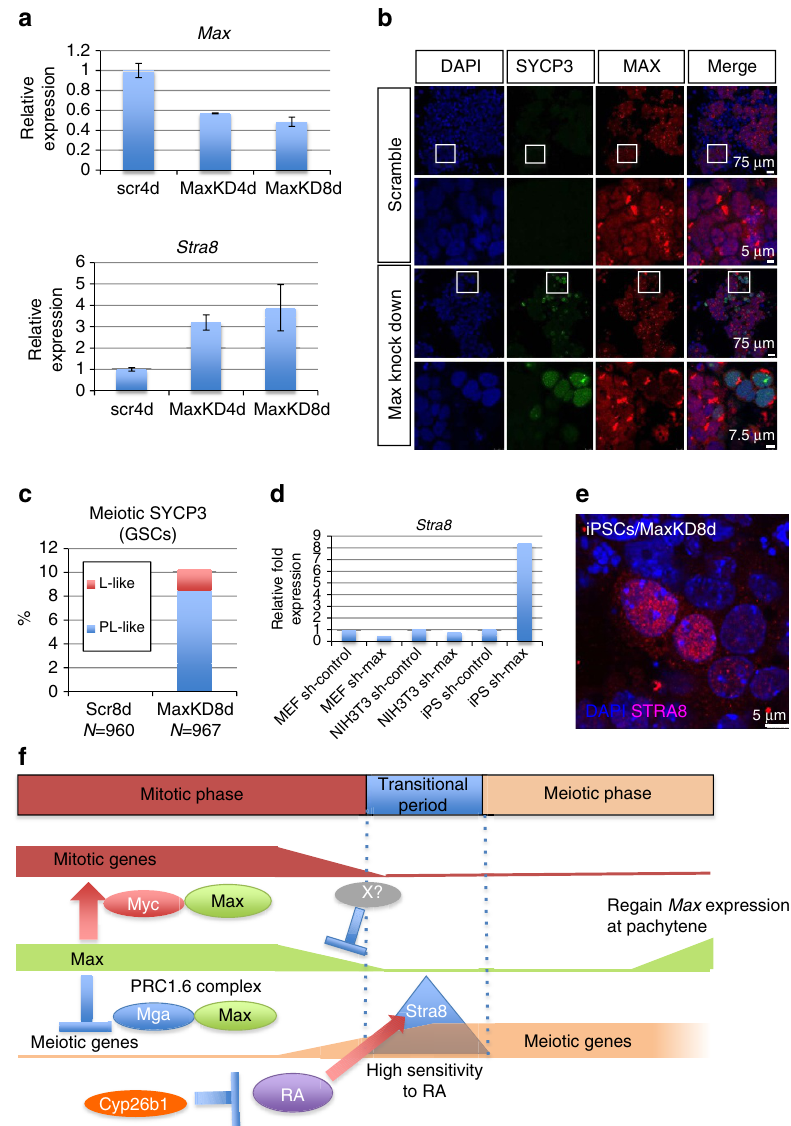
Figure 10 | Induction of meiosis-like changes in GSCs by knockdown of Max expression. ( a ) Effect of Max knockdown in GSCs on expression of the Stra8 gene. Lentivirus-mediated knockdown was conducted as described in Fig. 7. Upper panel shows the knockdown efficiency of Max expression ( n ¼ 3, means ± s.d.). ( b ) Effect of Max knockdown in GSCs on induction of the meiosis-like SYCP3-staining pattern. GSCs were subjected to knockdown with scrambled or specific sequences for Max expression and then applied to co-immunostaining analyses with antibodies against MAX and SYCP3. ( c ) Frequency of the meiosis-like SYCP3-staining pattern in GSCs subjected to lentivirus-mediated knockdown of Max expression. ( d ) Effect of